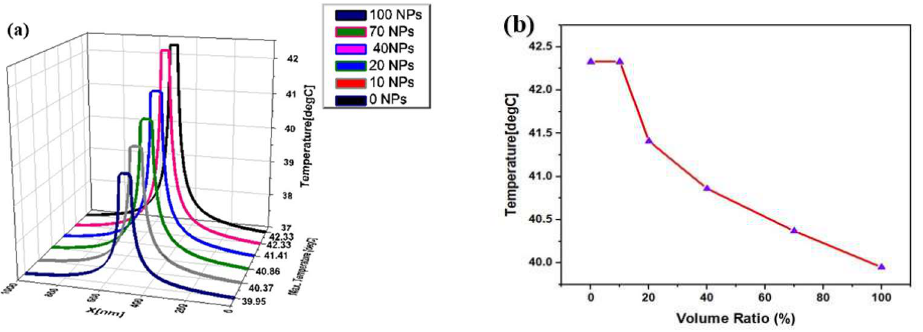
Figure 10. ( a ) Radial distribution of temperature after 3 µ s of heating process for different levels of surface coating and ( b ) temperature evolution for different volume coverage ratios.